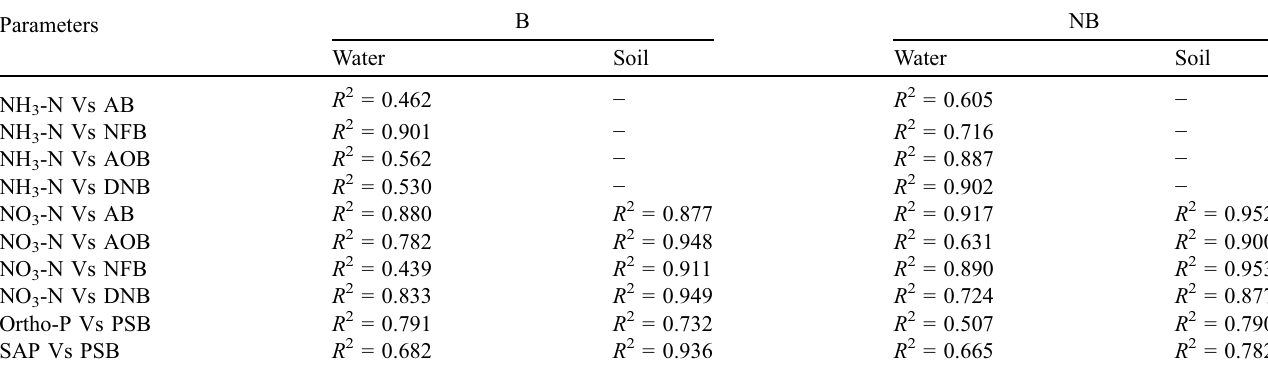
Table 8. Co-relation between nutrient parameters and mineralizing bacterial populations in water and soilin L. vannamei culture. Parameters